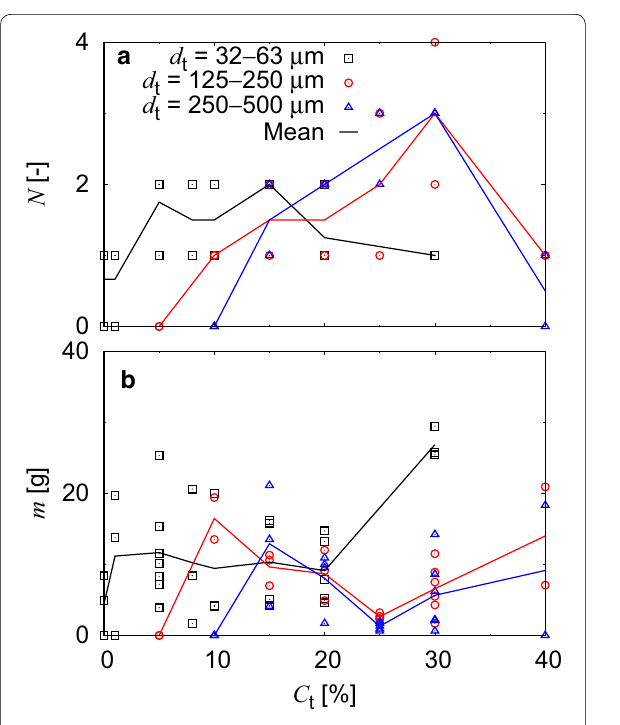
Fig. 8 Aggregate formation according to amount of tephra. Influence of tephra concentration, C t , and diameter, d t , on aggregate formation in EXP3–5 ( C s = 10% and t = 5min ): a number of aggregates, N , and b mass of aggregate, m . Black squares, red circles, and blue triangles indicate results in EXP3, EXP4, and EXP5, respectively